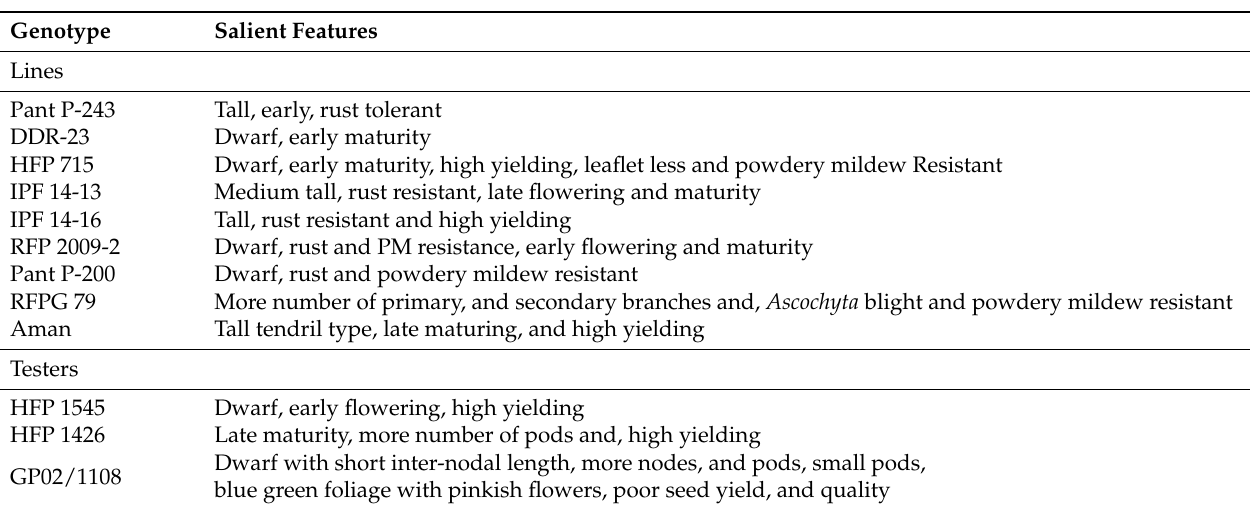
Table 1. Salient features of the lines and testers